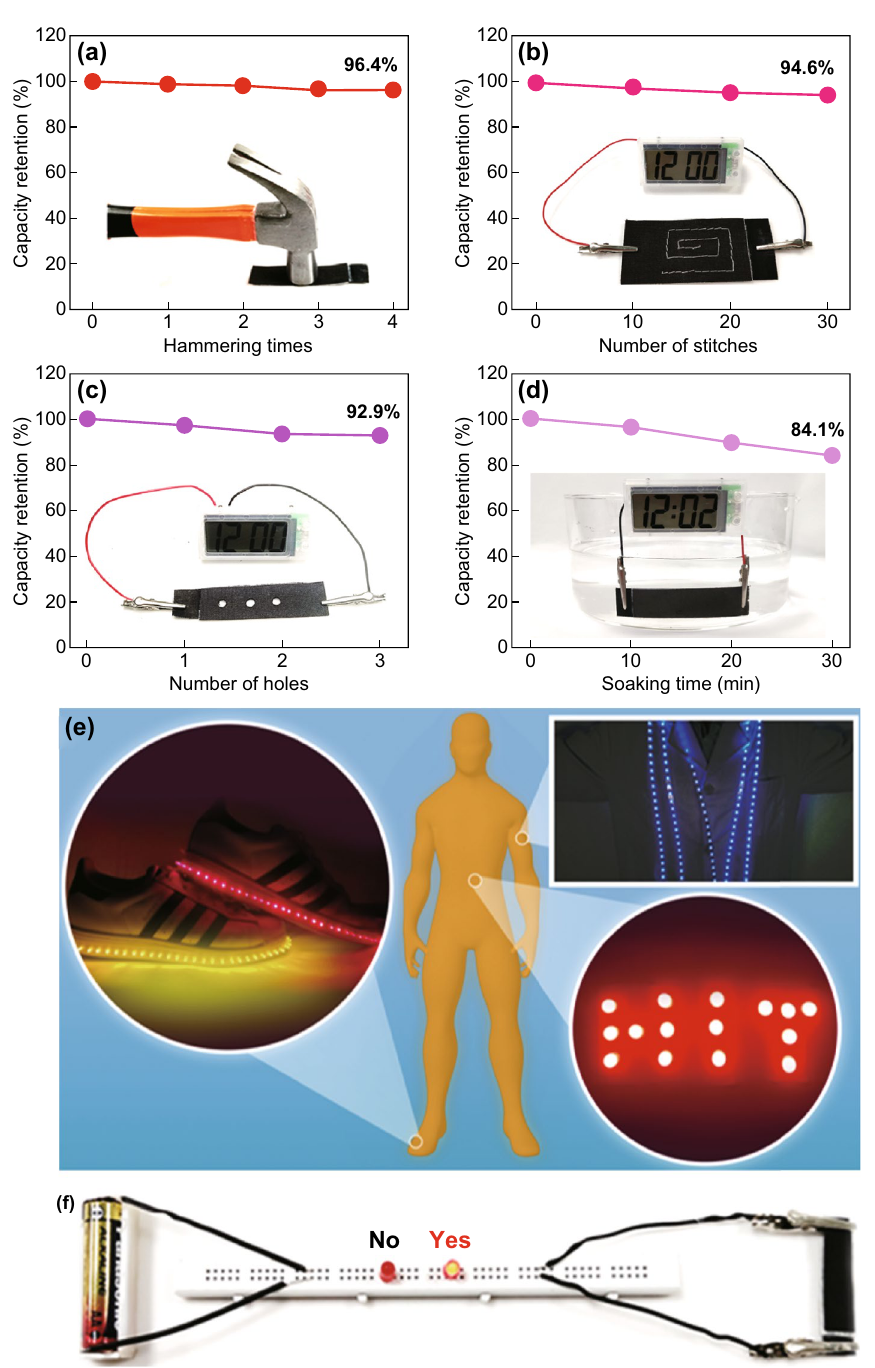
Fig. 5 Electrochemical performance of the ZIB after a hammering, b sewing, c punching, and d soaking test. e Various LED patterns (HIT, luminous shoes, light clothes) powered by designed batteries and visual voltage contrast demo. f The visual contrast demo consists of a standard voltaic battery and a small ZIB (1 × 4 cm 2